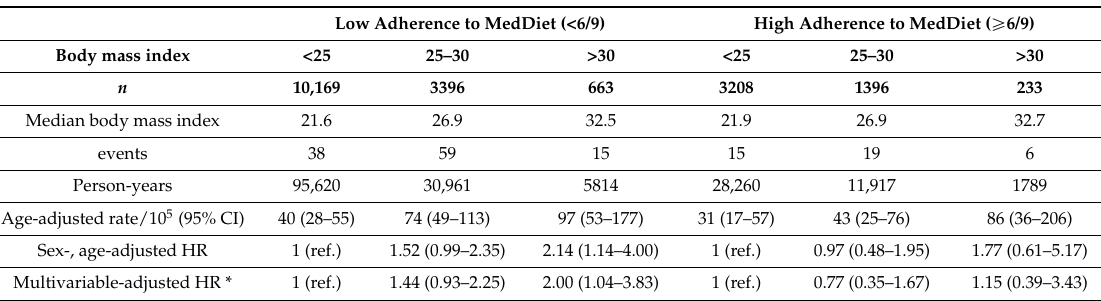
Table 2. Relative risk (hazard ratios and 95% confidence intervals) of incident cardiovascular disease (myocardial infarction, stroke or cardiovascular death) according to baseline body mass index and adherence to MedDiet. The SUN project 1999–2014.